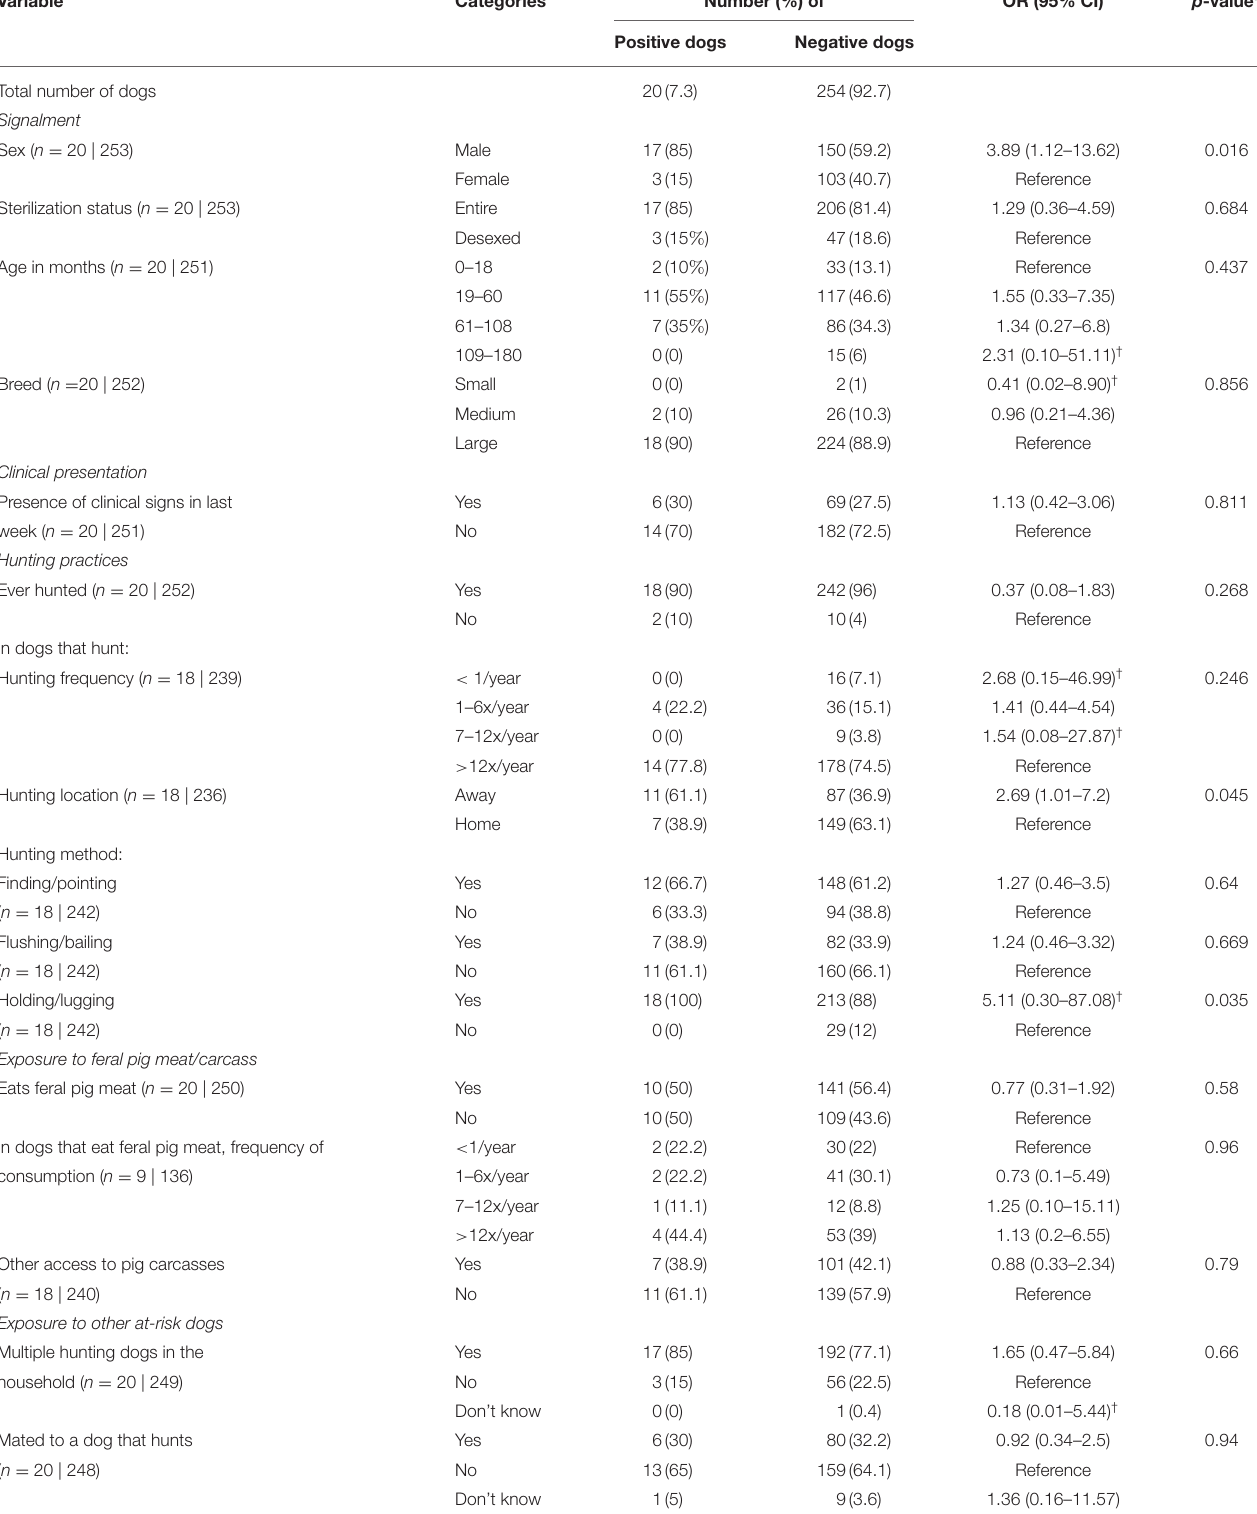
TABLE 4 | Unconditional associations between Brucella suis seropositivity and signalment, clinical presentation and husbandry